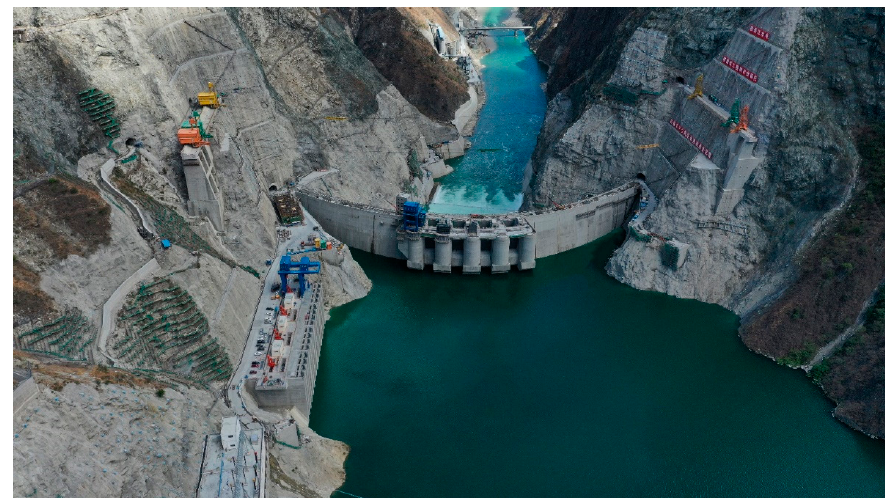
Figure 7. The Yangfanggou hydropower project.